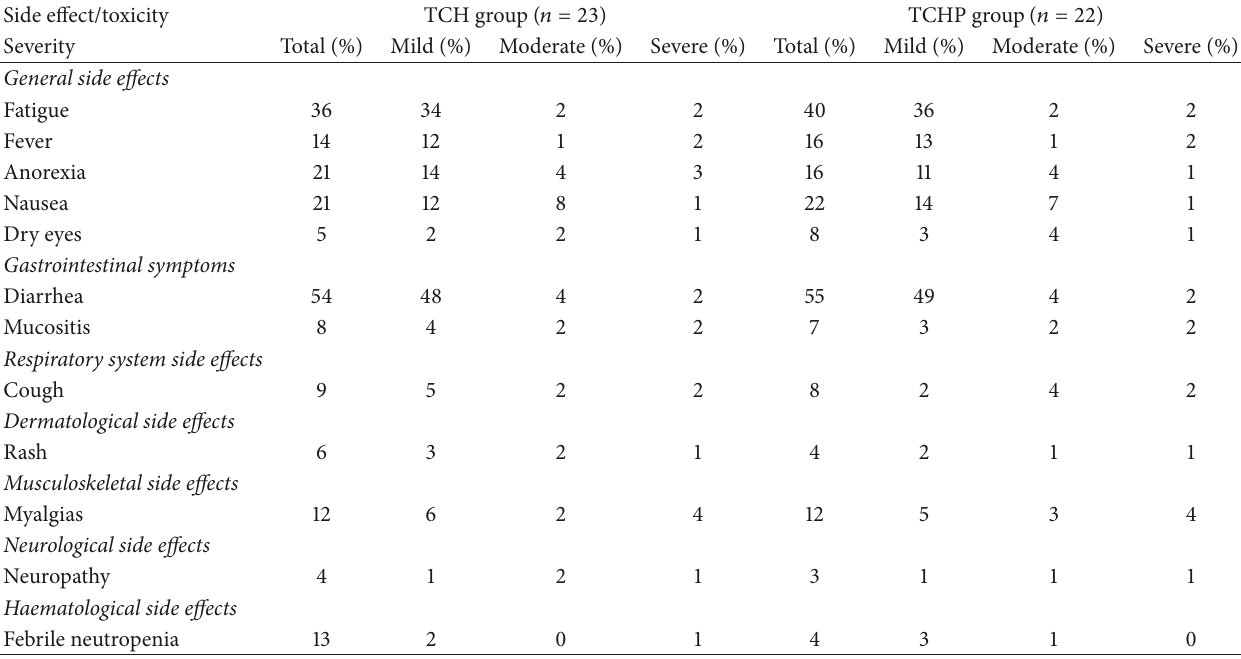
Table 2: Reported side effects and toxicities associated with TCH versus TCHP. The numbers reflect percentages of patients with recorded side effects and toxicities in their electronic medical files. Mild, moderate, and severe side effects are correlated with CTCAE grade 1, grades 2-3, and grade 4 side effects,